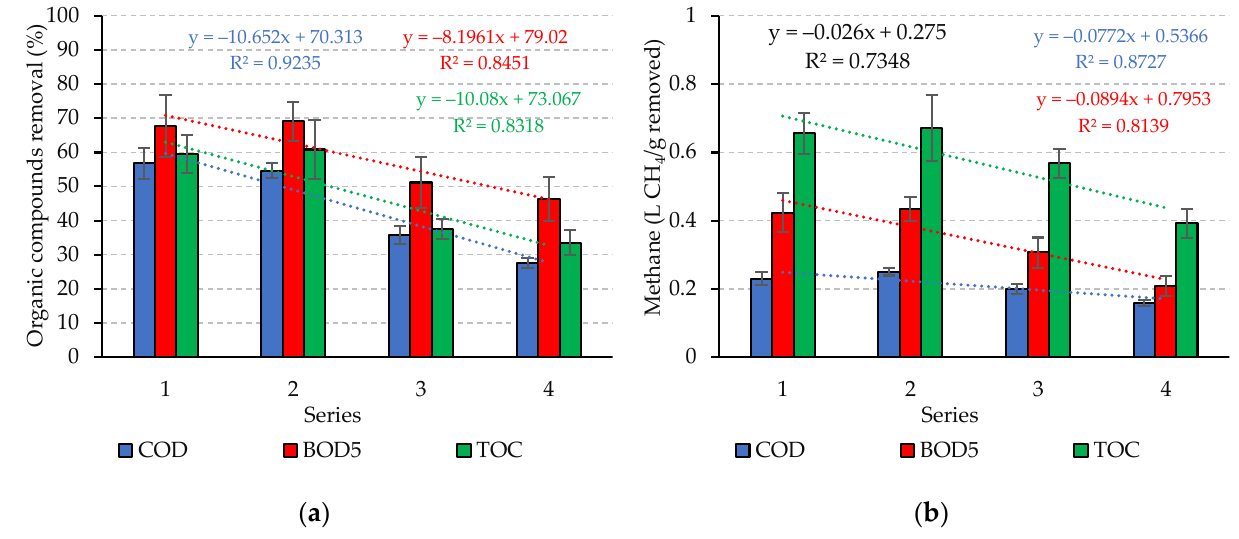
Figure 4. The efficiency of anaerobic confectionery wastewater treatment in stage 1: ( a ) organic compound removal; ( b ) CH 4 production per g of organic substances removed ( b ). Table 5. Removal of organic compounds as COD, BOD 5 , TOC, and production of CH 4 in stage 1.